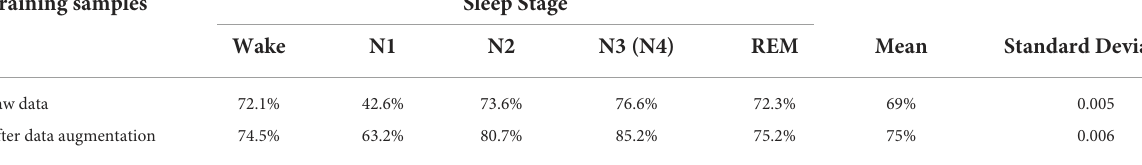
TABLE 3 Classification accuracy of each stage before and after data augmentation. Training samples